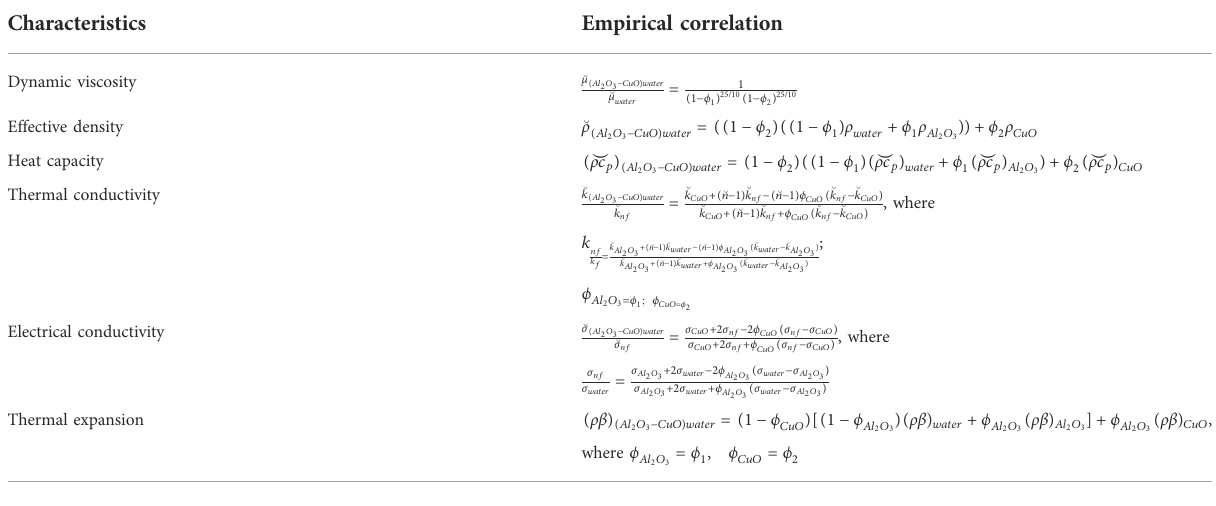
TABLE 2 Empirical correlations for second-generation heat transfer fl uids (hybrid nano fl uids) (Ahmed et al., 2021).